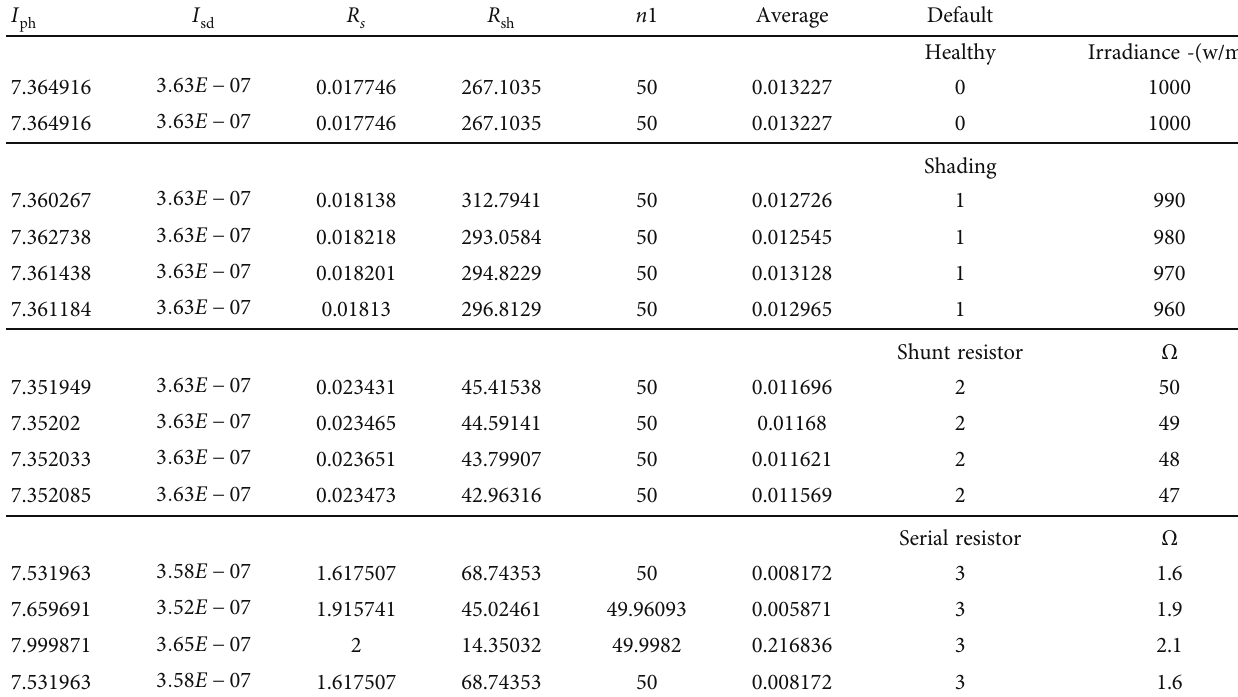
Table 3: Estimated parameter vectors for each fault.